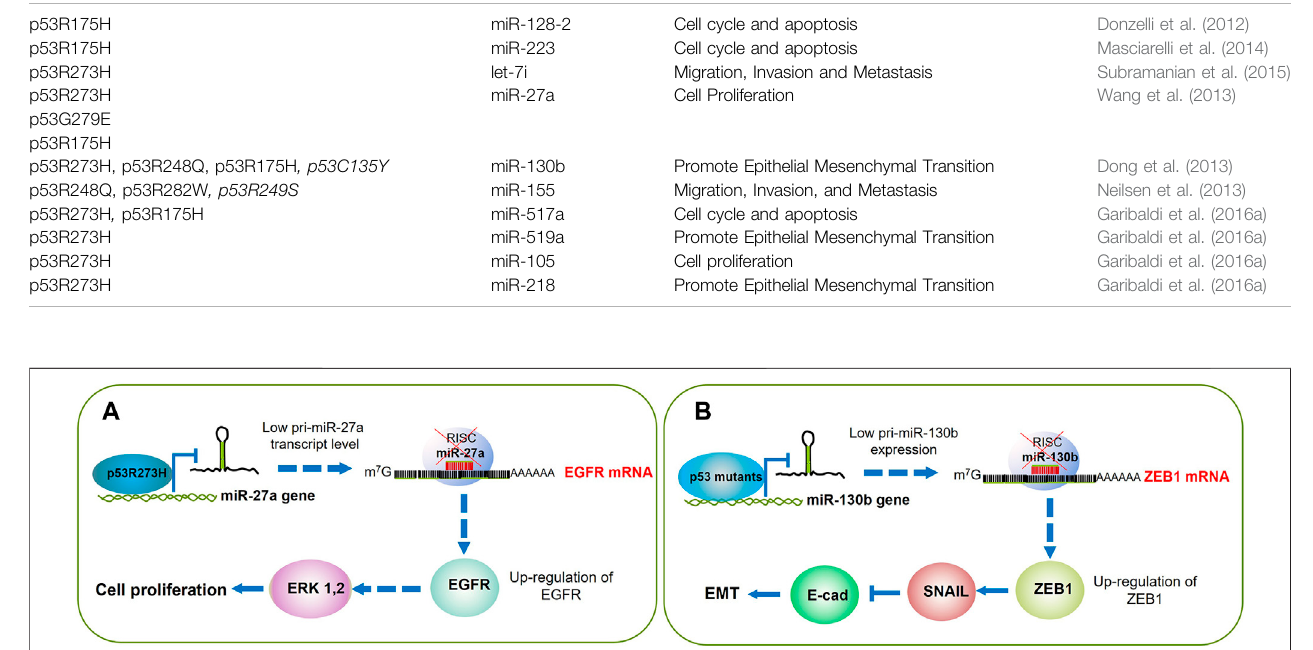
FIGURE 3 | p53 mutants boost cell proliferation and EMT through gene promoter silencing. (A) p53R175H binds to and silences the miR-27a gene promoter; this leads to higher expression of its EGFR target. Then EGFR triggers the cell signaling that results in ERK 1,2 activation and cell cycle progression. (B) The mutants p53R175H, p53R273H, P53C135Y, and P53R248Q turn off miR130b expression, which results in the accumulation of ZEB1, that in turn activates SNAIL and consequent silencing of E-cadherin; altogether leading to activation of the EMT program.